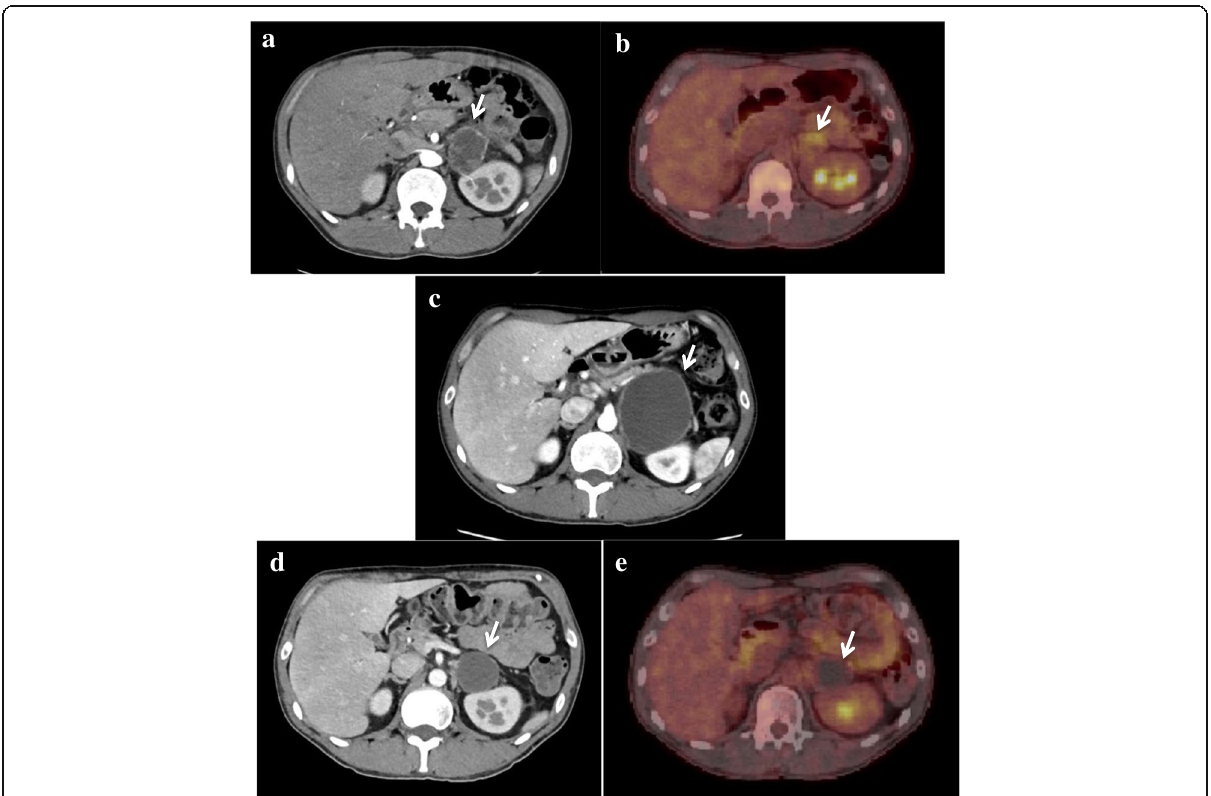
Fig. 5 Distant metastasis to the left adrenal gland on imaging studies. a CT before the second radiotherapy with proton beam. b PET before the second radiotherapy with proton beam; remarkable fluorodeoxyglucose (FDG) uptake was found. c CT at the end of the second radiotherapy; larger but cystic and non-enhanced mass was observed. d , e CT and PET 8 months after the completion of the second radiotherapy; the size of the mass was remarkably reduced, and the blood flow nor the FDG uptake was not